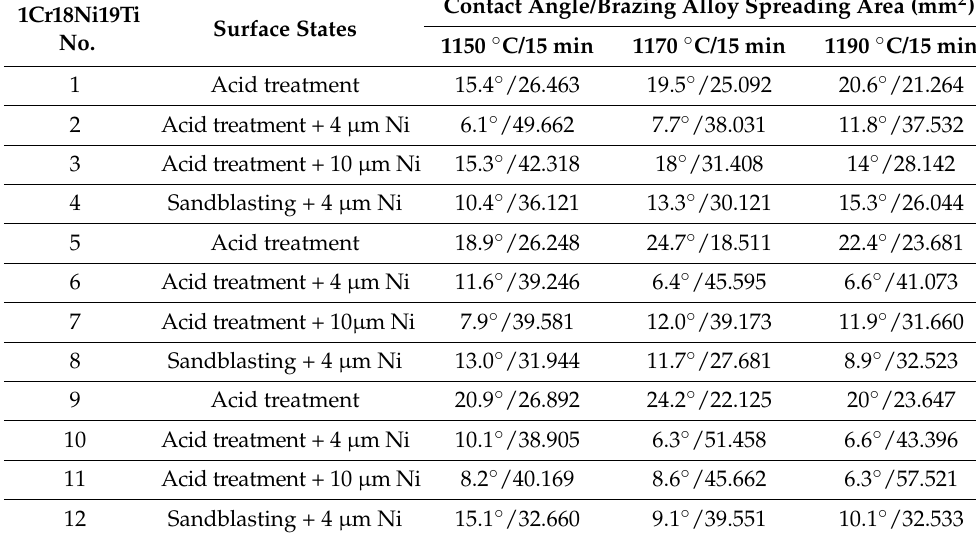
Table 2. Contact angle and spreading area of brazing